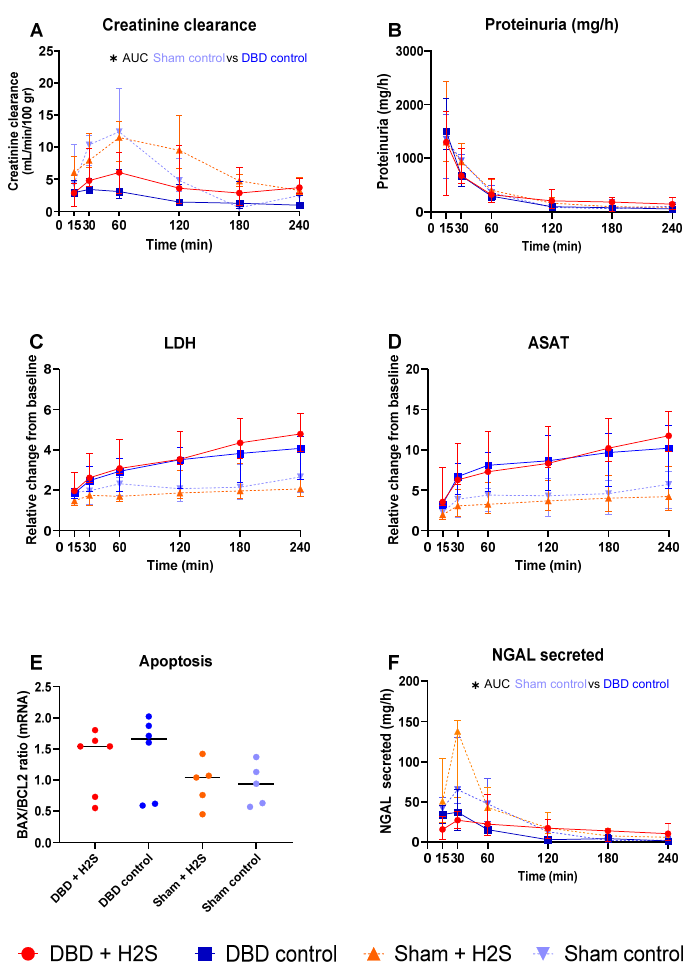
Figure 5. Renal function and injury markers. ( A ): Creatinine clearance (mL/min/100 gr). ( B ): Proteinuria (mg/h). ( C ): LDH (relative change from baseline). ( D ): ASAT (relative change from baseline). ( E ). BAX/BCL2 ratios, measured in tissue after NMP. ( F ): NGAL secretion in urine (mg/h). Data presented as median + interquartile range. * p < 0.05. Abbreviations: AUC = area under the curve. LDH = lactate dehydrogenase. ASAT = aspartate aminotransferase. NGAL = urinary neutrophil gelatinase-associated lipocalin. BAX = bcl-2-like protein 4. BCL2 = B-cell lymphoma 2.